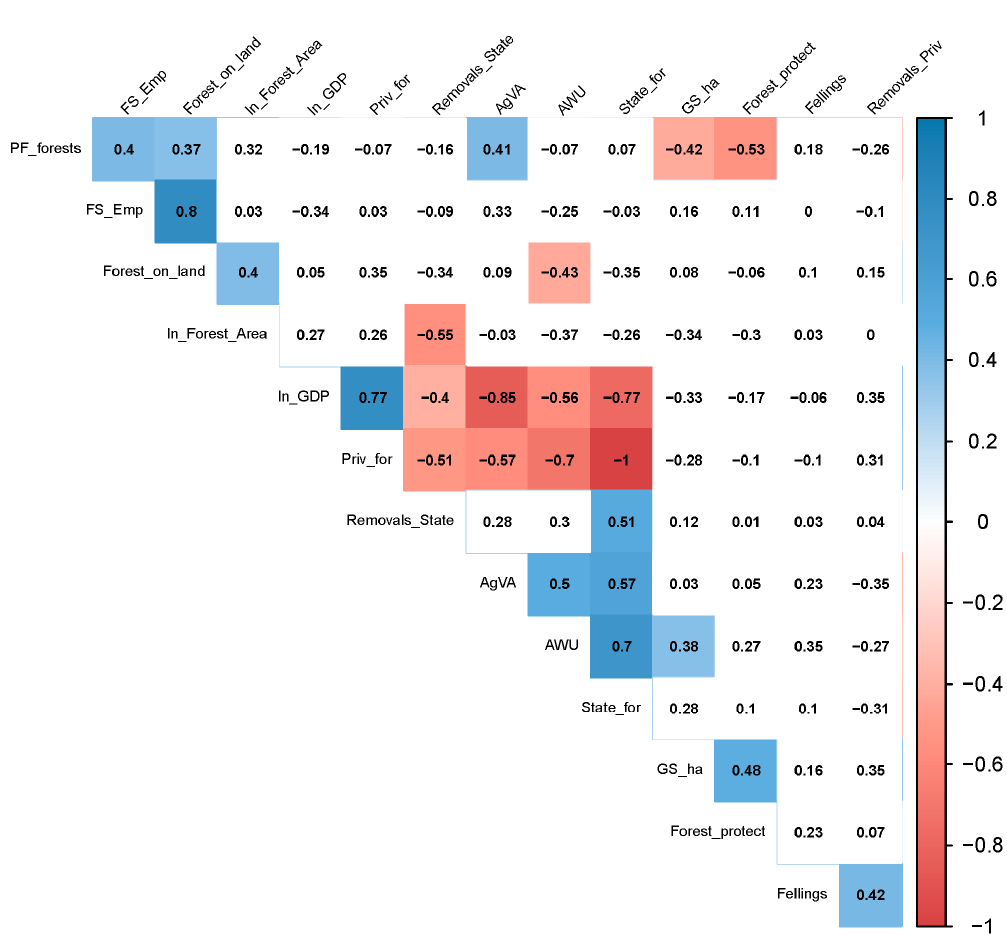
Figure 1. Correlation between quantitative variables (Blue color means there is a positive correlation; red means a negative correlation. The darker the color, the stronger the correlation. White square means there is no a significant correlation). Table 1. Summary statistics.